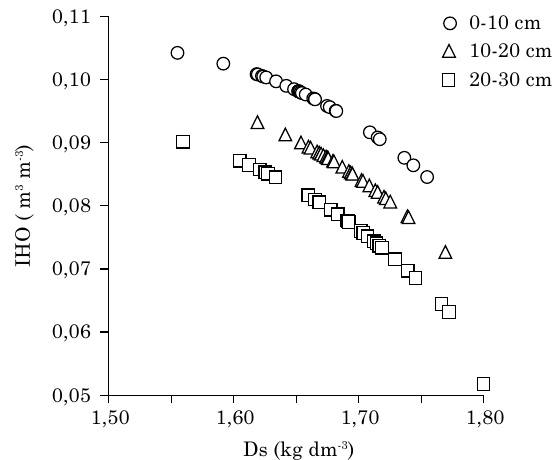
Figura 3. Intervalo hídrico ótimo (IHO) em função da densidade do solo (Ds) para três camadas de solo (0-10, 10-20 e 20-30